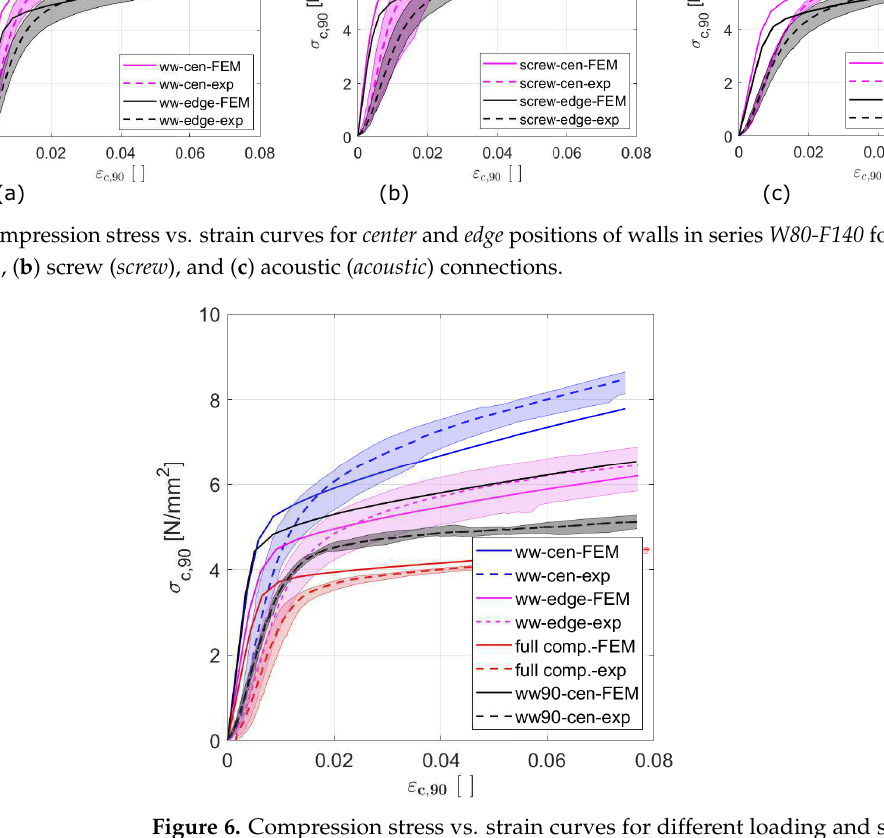
Figure 6. Compression stress vs. strain curves for different loading and supporting positions and deck outer layer orientations for wood-to-wood contact in series W80-F140